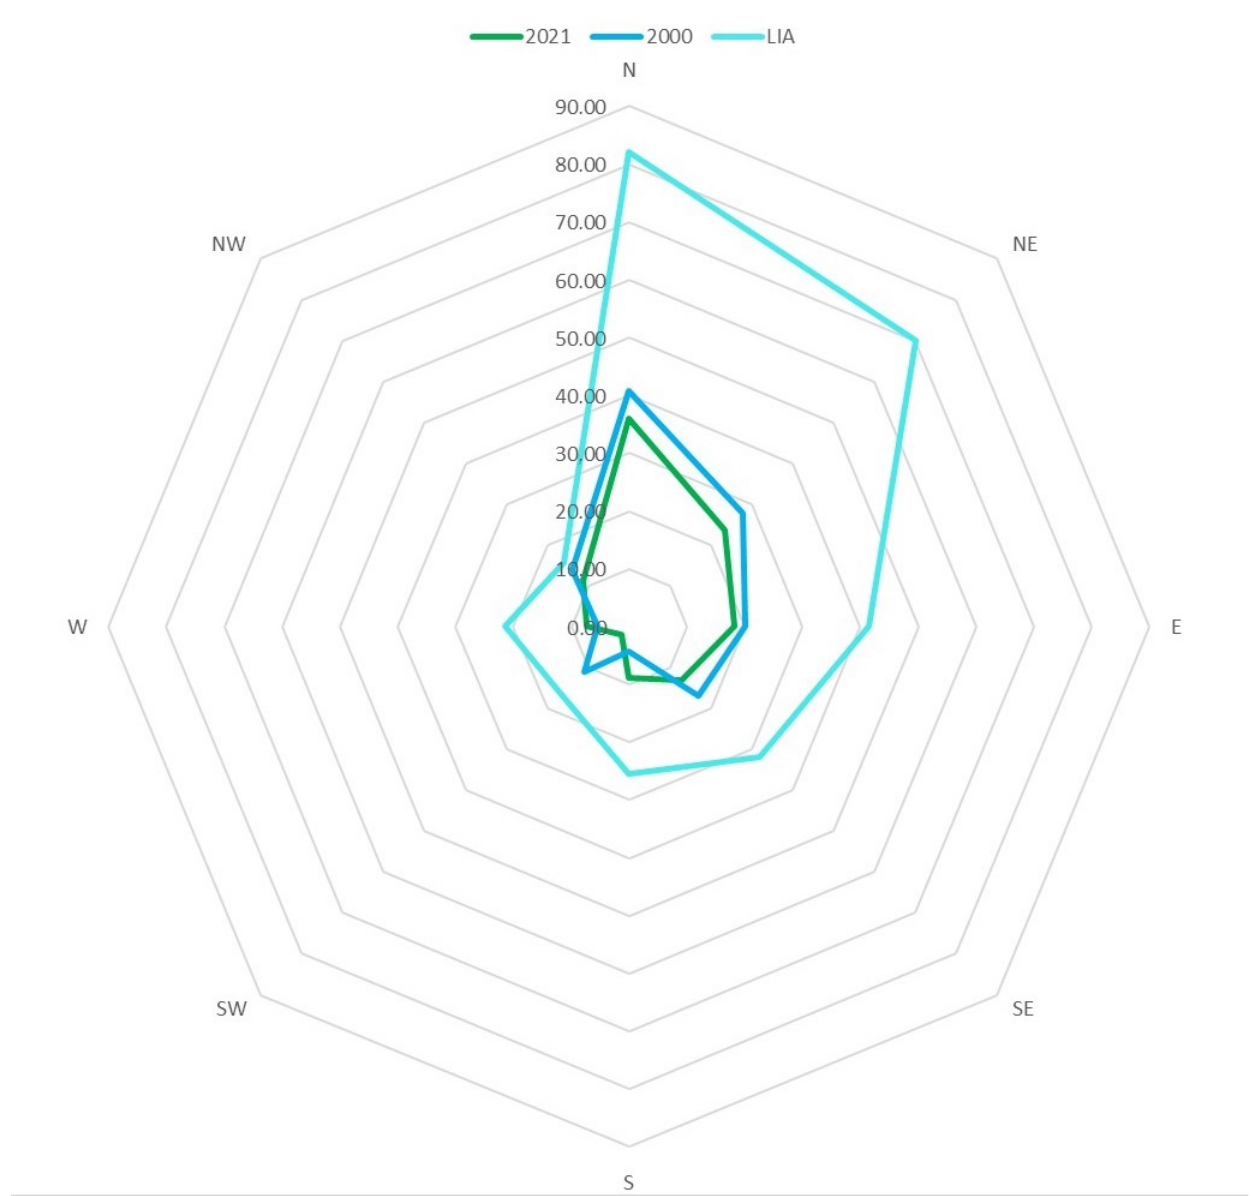
Figure 11. Aspect distribution of the glacier area in the LIA, 2000, and